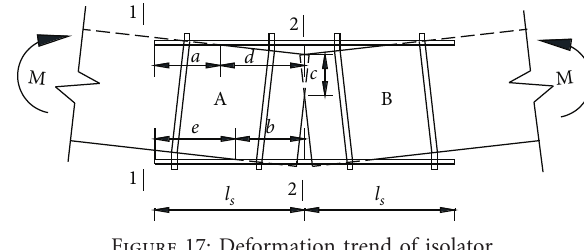
Figure 17: Deformation trend of isolator.